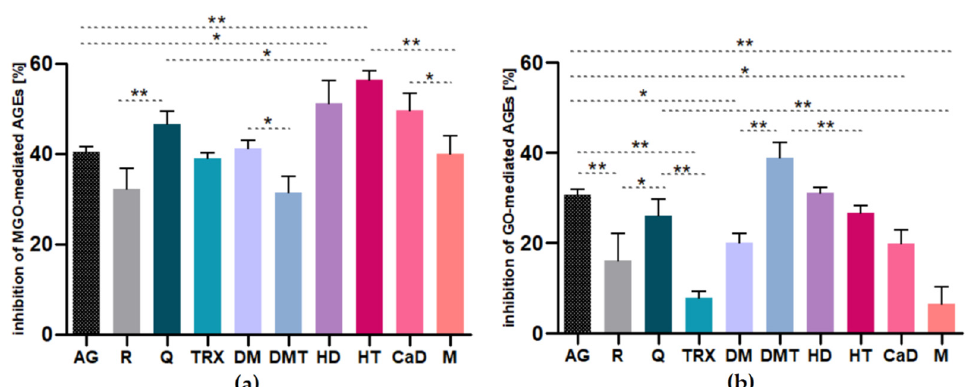
Figure 2. Anti-glycation activity after seven days of incubation of bovine serum albumin with glycative agents (5 mM) and tested compound (1 mM) expressed as % inhibition of: ( a ) MGO-mediated-AGE formation, ( b ) GO-mediated-AGE formation. The results are representative of three experiments performed in triplicate ± SD. Data were analyzed by one-way analysis of variance ANOVA ( p < 0.0001) followed by Tukey’s multiple comparison test; only significant differences are displayed: * p < 0.05, ** p < 0.01. Abbreviations: AG, aminoguanidine; R, rutin; Q, quercetin; TRX, troxerutin; DM, diosmin; DMT, diosmetin; HD, hesperidin; HT, hesperetin; CaD, calcium dobesilate; M, metformin.